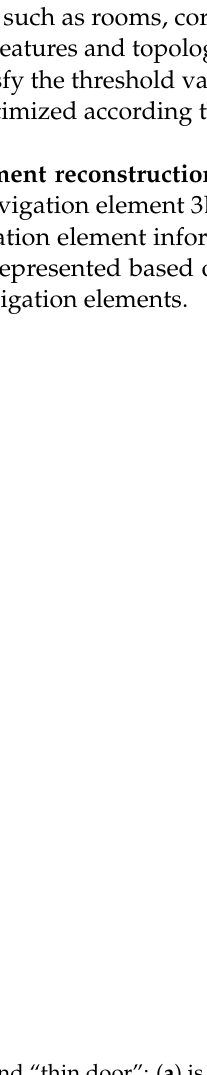
Figure 2. “thick door” and “thin door”: ( a ) is a photo of “thick door”; ( b ) is the point cloud of “thick door”; ( c ) is a photo of “thin door”; and ( d ) is the point cloud of “thin door”.